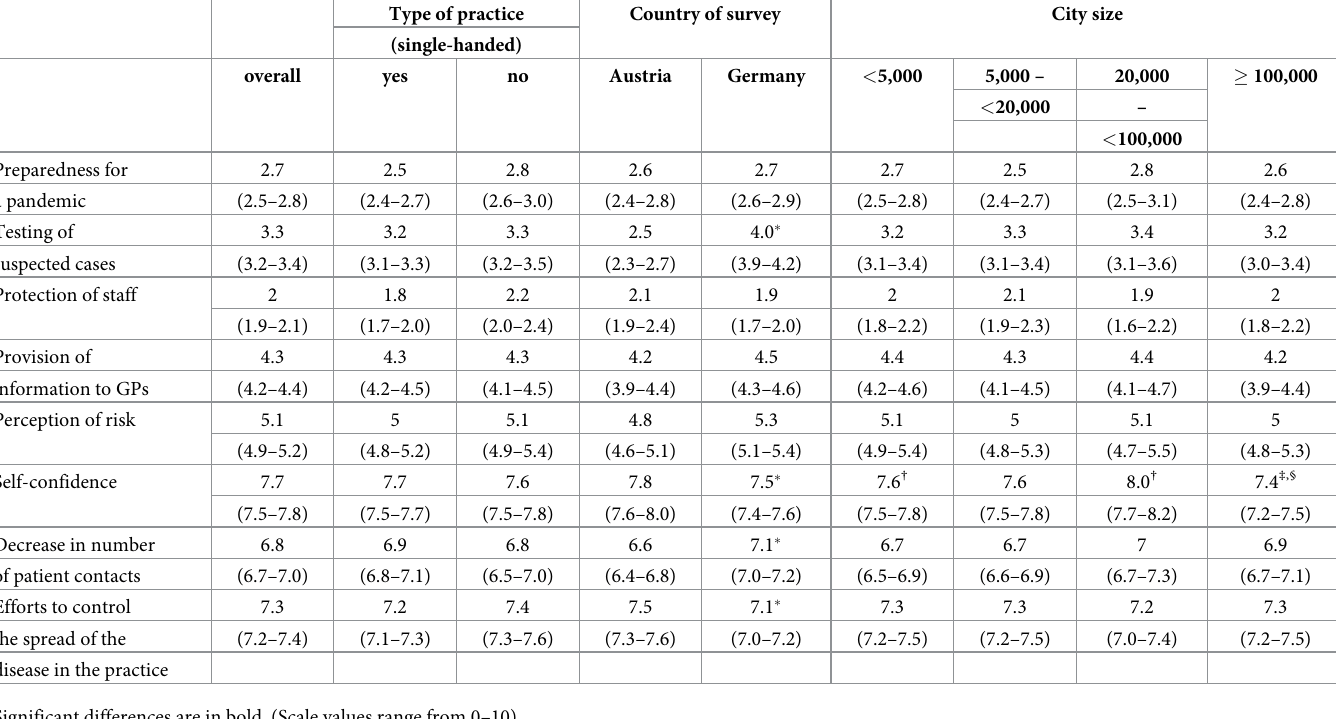
Table 2. Mean and 95%CI for each factor of the evaluation of the pandemic for the whole group and subgroups. Type of practice Country of survey City size (single-handed)